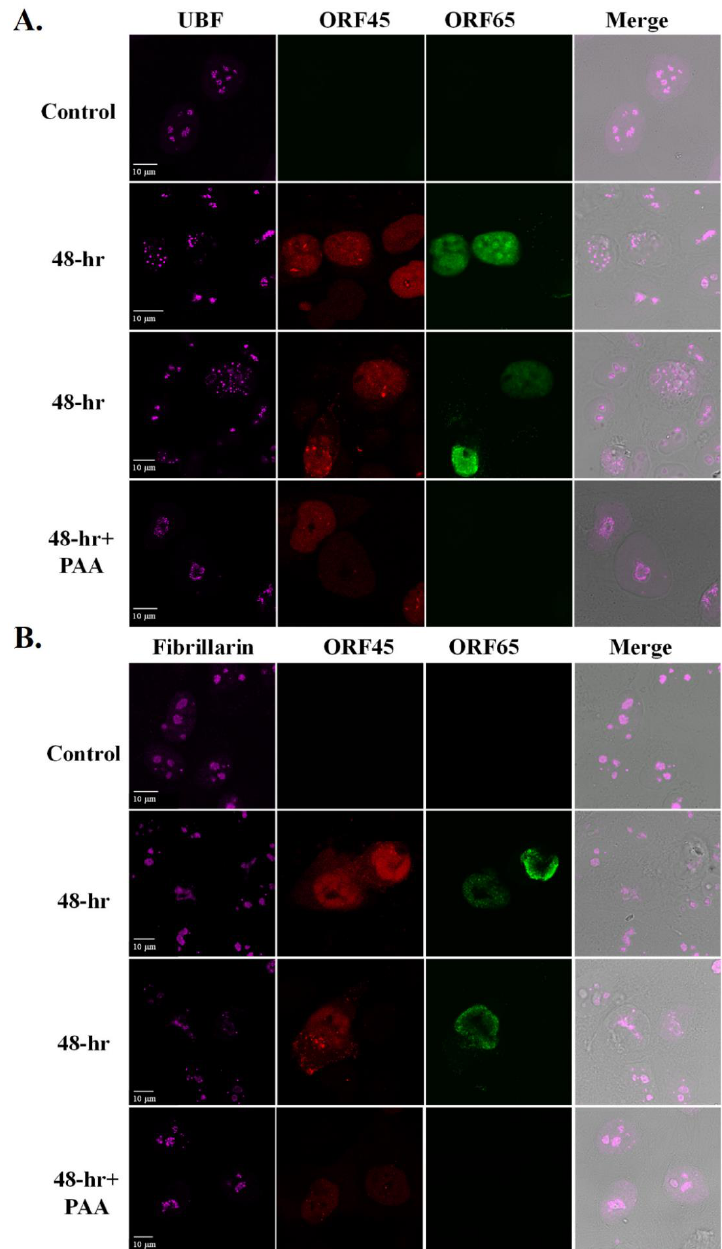
Figure 3. Redistribution of UBF and Fibrillarin depends on viral DNA replication. BAC16-BFP-mCherry-infected iSLK cells were treated for 48 h with 1µg/mL Dox and 1 mM n-Butyrate to induce lytic reactivation. Treatment with PAA was carried 2 h prior to lytic induction and continued during lytic reactivation. Infected iSLK cells that were either left untreated or induced to undergo lytic reactivation with no PAA treatment were used as control. mCherry-ORF45 was used to track cells undergoing lytic reactivation while ORF65, detected with anti-ORF65 antibody followed by anti-mouse Alexa Fluor 488, was used to distinguish late viral lytic stage and effectiveness of PAA treatment. Cells were then stained with anti-UBF ( A ), or anti-Fibrillarin ( B ) followed by anti-rabbit Alexa Fluor 647-conjugated secondary antibody. Right-hand columns show the merged output of the nucleolar proteins immunofluorescence with differential interference contrast (DIC) microscopy